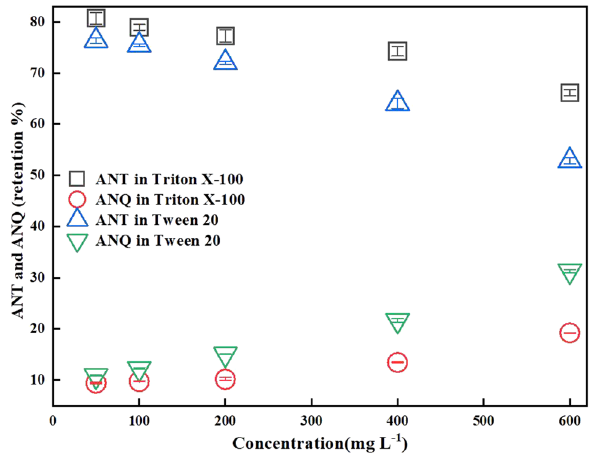
Figure 3. Transformation of 20 mg L -1 ANT and accumulation of ANQ by 1.88 U mL -1 laccase with 2 mM HOBt in the presence of different concentrations of Tween 20 and Triton X-100 in 0.2 M sodium acetate solutions, pH 4.5 at 30 °C after 24 h incubation period. Error bar represents standard deviations (n =